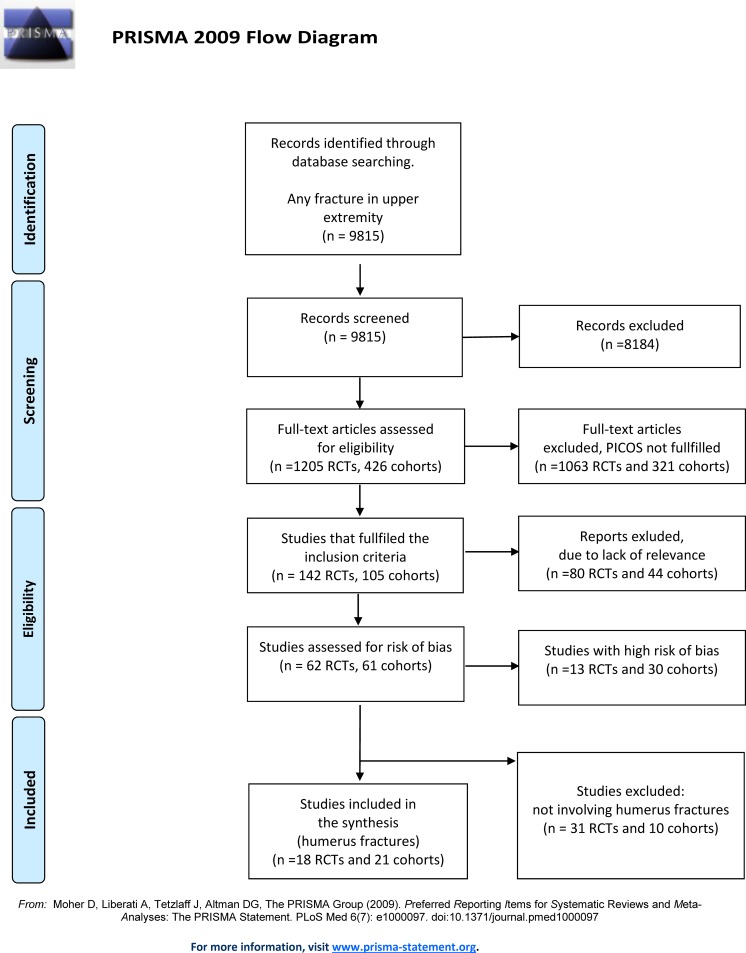
PRISMA flow-chart.